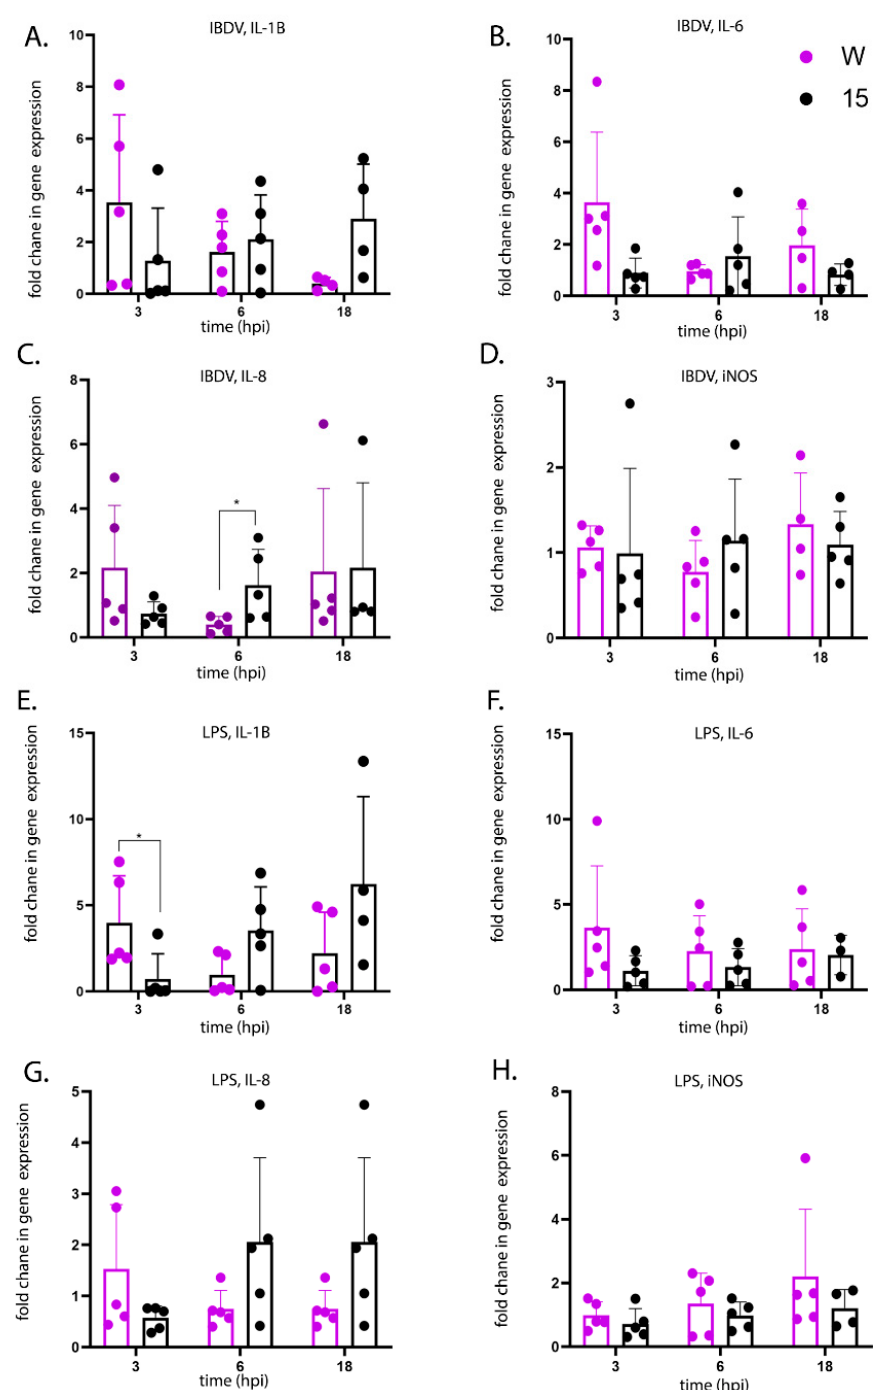
Figure 6. Primary bursal cells isolated from uninfected line W birds and stimulated with LPS ex vivo showed a more rapid up-regulation of pro-inflammatory cytokine gene expression compared to cells isolated from uninfected line 15 birds. Primary bursal cells were isolated from the BF of 5 uninfected line W birds and 5 uninfected line 15 birds. The cells were either infected ex vivo with IBDV strain UK661 (MOI 3) ( A – D ) or stimulated ex vivo with LPS (100 ng/mL) ( E – H ). At the indicated time-point post-infection or stimulation, RNA was extracted from the cells, and subjected to RTqPCR. The fold change in the expression of IL-1 β ( A , E ), IL-6 ( B , F ), IL-8 ( C , G ) and iNOS ( D , H ) was quantified, normalized to the housekeeping gene RPLPO and expressed relative to mock-infected or mock-stimulated controls at the same time points in a ΔΔ CT analysis. Data passed Shapiro-Wilk normality tests before being analysed by one-way ANOVA and Tukey’s multiple comparison tests (* p < 0.05).